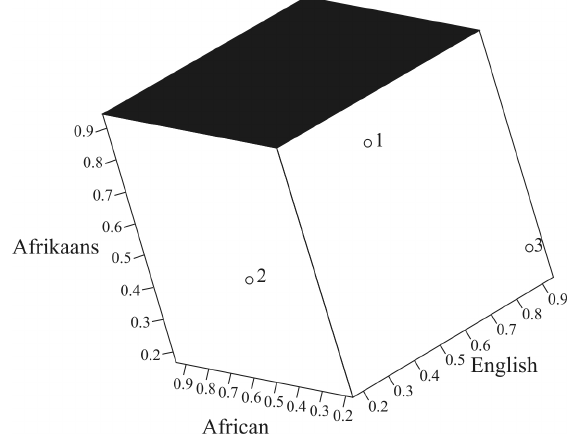
Figuur 1: Grafiese voorstelling van die afstand tussen die drie taalgroepe (1 = Afrikaans, 2 = Afrika taal, 3 = Engels) Die stappe wat gevolg is om die dimensies te interpreteer, het aangedui dat verskille tussen die groepe ten opsigte van